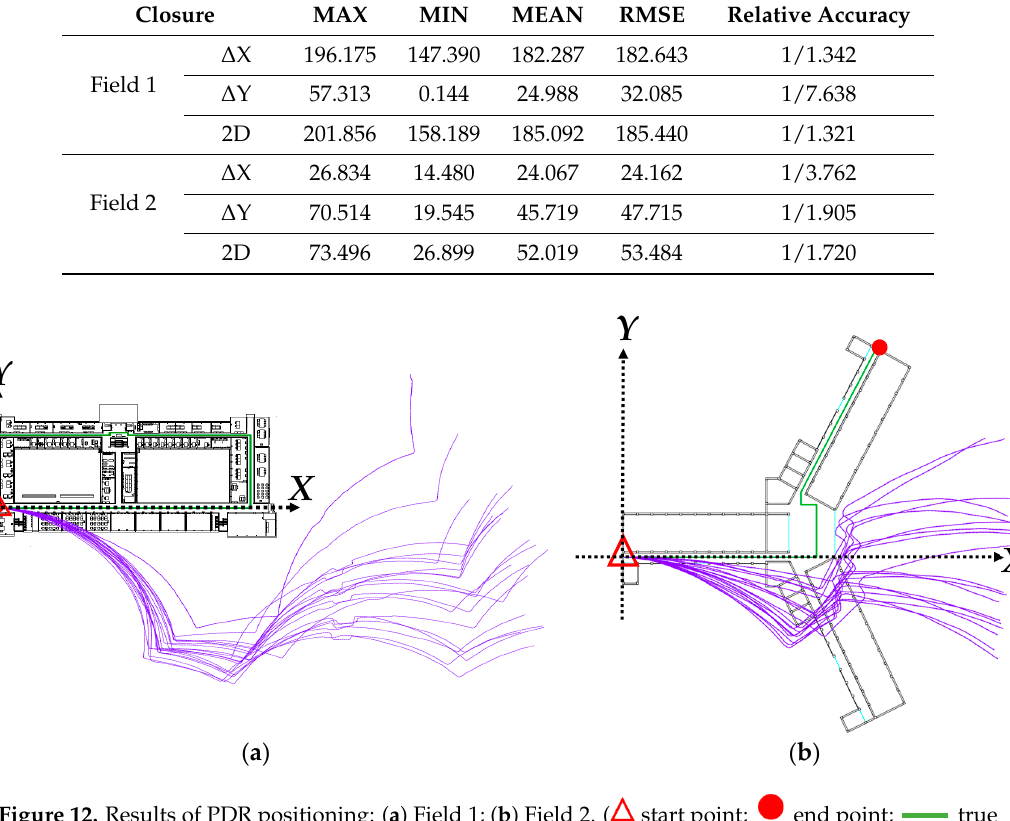
Figure 6. Paths and corner calibration points in the experimental fields: ( a ) Field 1; ( b ) Field 2. ( start point; end point; calibration point on the corner; true path.)